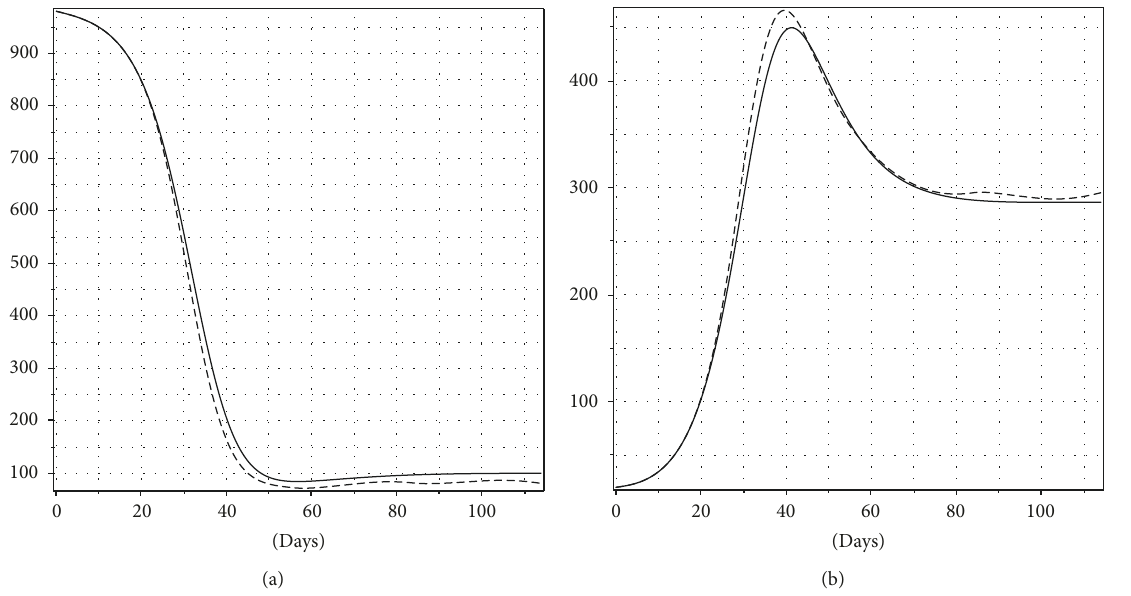
Figure 10: Susceptible (a) and infected (b) human dynamics with constant (solid curve) and biweekly (dash curve)